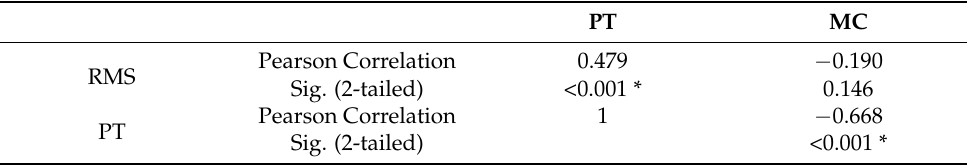
Table 2. Results of Pearson’s correlation values and significance for correlations between root-mean- square (RMS), printing time (PT), and material consumption (MC). PT MC Pearson Correlation 0.479 − 0.190 RMS Sig. (2-tailed) <0.001 * 0.146 Pearson Correlation 1 − 0.668 PT <0.001 *